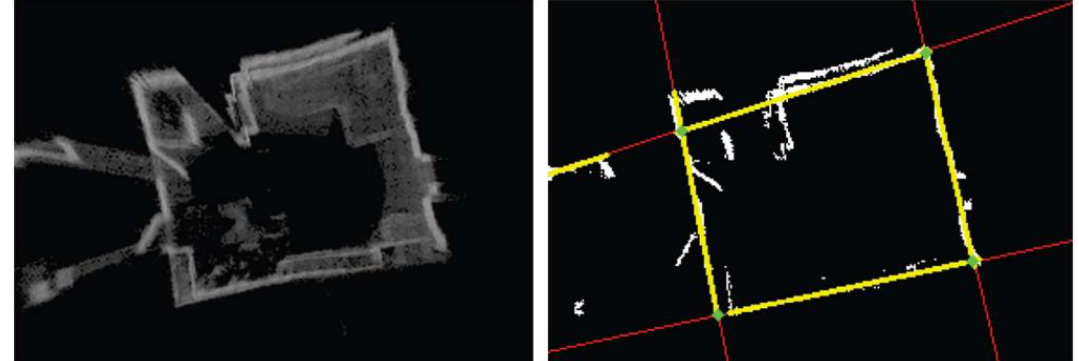
Figure 8. Results of wall detection. Visualization of a heat map provided by projecting the point cloud onto the floor (lightened up to improve visibility) (left). The analyzed heat map (right) [29]. 3.